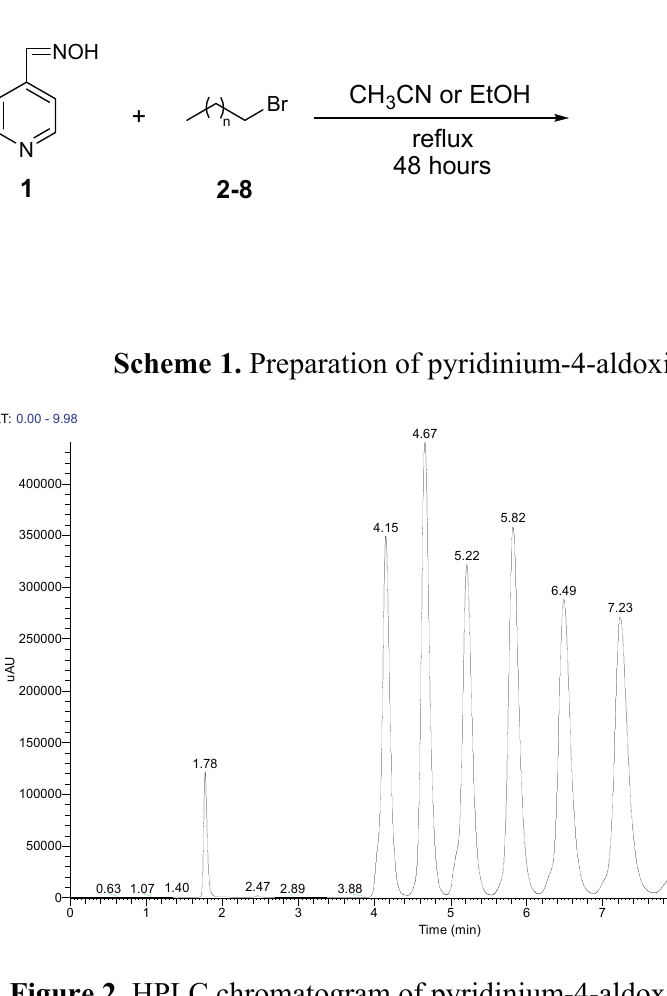
Figure 2. HPLC chromatogram of pyridinium-4-aldoxime salts